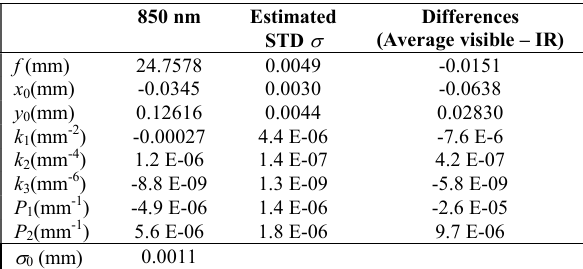
Figure 5. Estimated standard deviations for focal length, principal point coordinates of both camera heads for all experiments.